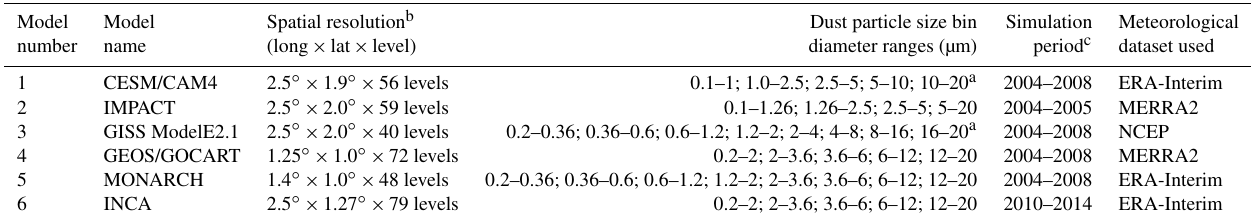
Table 1. Overview of global model setups used in this study.